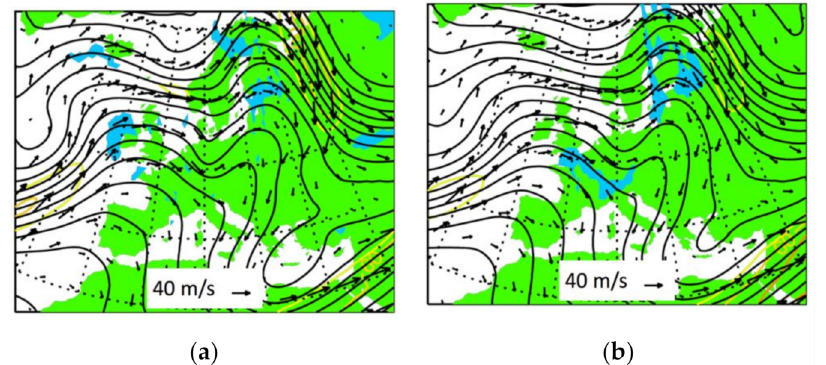
Figure 3. Geopotential height (black contours), wind situation (arrows), and regions of potential contrail formation (blue) over Europe on 18 December 2015, 12.00 p.m. UTC based on European Centre for Medium-Range Weather Forecasts (ECMWF) ERA-Interim re-analysis data on pressure levels 250 hPa ( a ) and 200 hPa ( b